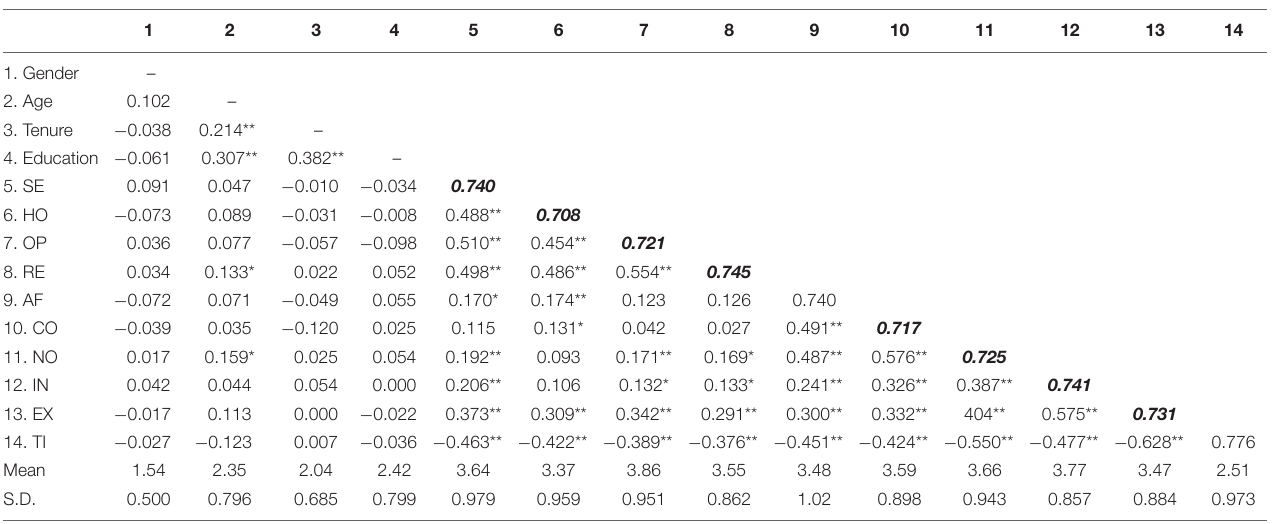
TABLE 4 | Descriptive statistics, correlations of variables and the results of discriminant validity